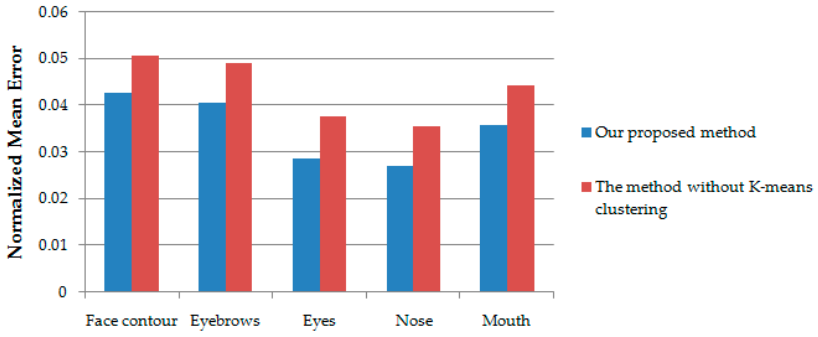
Figure 13. Normalized mean errors of our proposed method versus the method without K-means clustering.